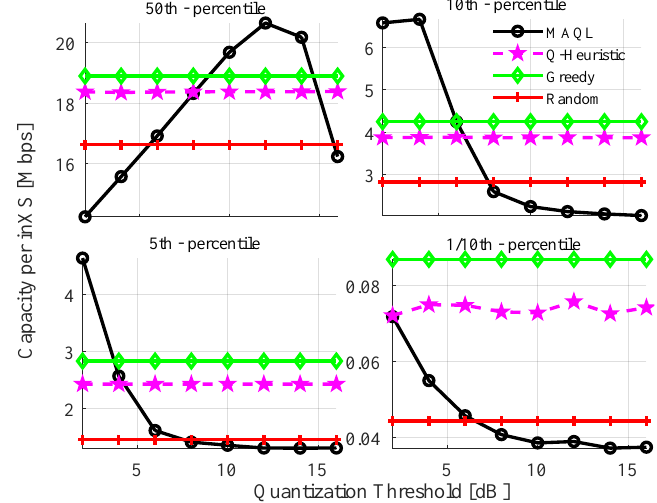
Figure 7. Sensitivity to quantization threshold, s th .